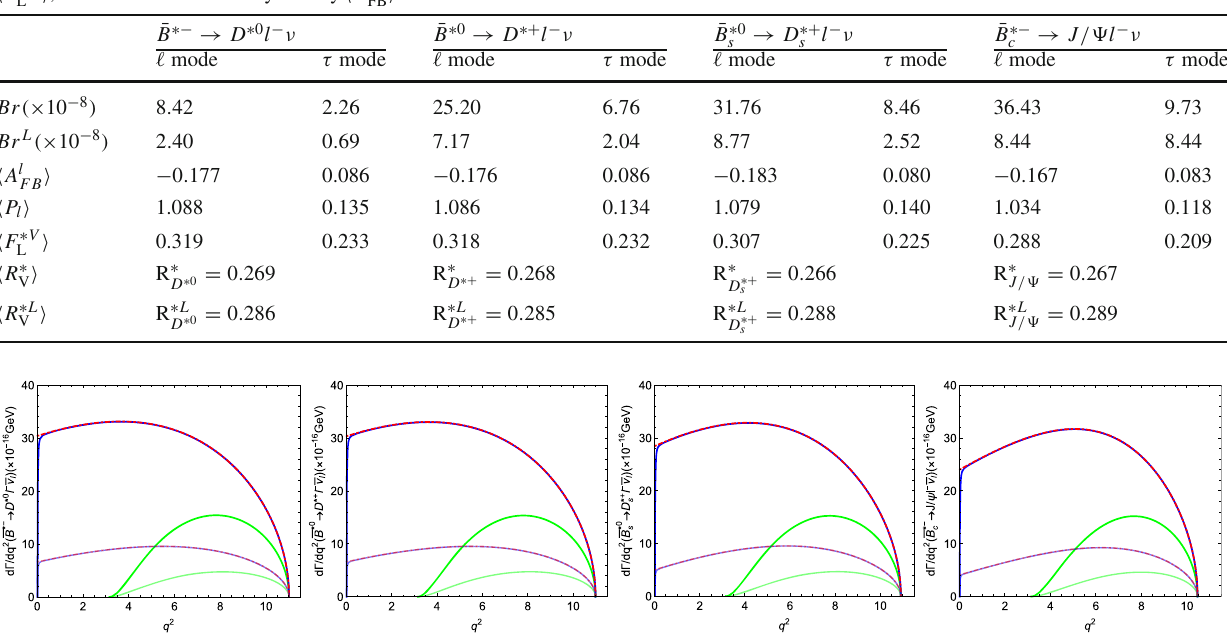
(cid:10) andtheratioofbranch- FB